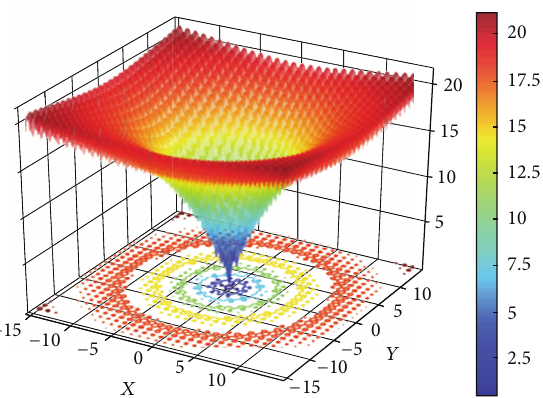
Figure 4: This is a two-dimensional surface plot of Ackley’s function. The global optima is at [0,0] where the function evaluates to 0.